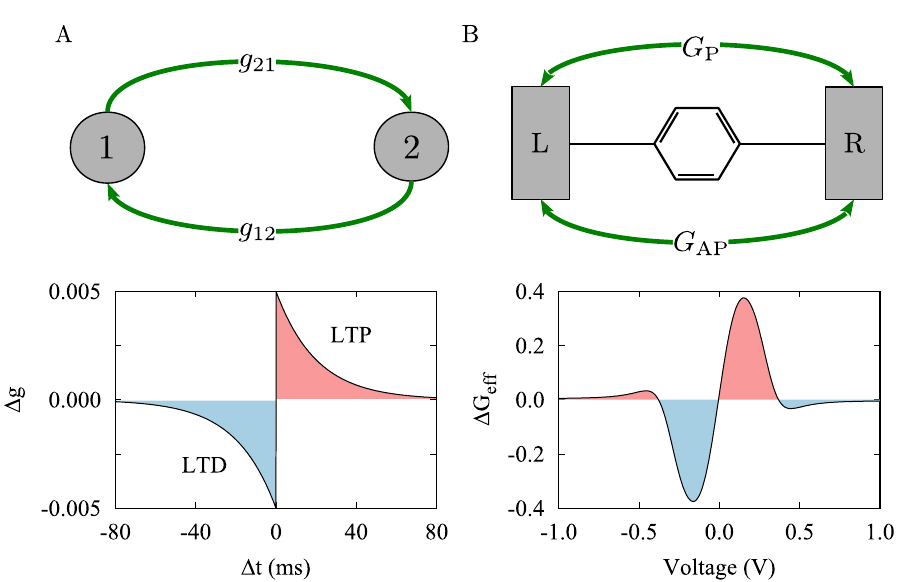
Fig 1. Schematic representation of the two-neuron motif and MTJ. ( A ) (Top) Two neuronal phase oscillators (1/2) reciprocally connected via synapses of strength g 21 / g 12 . (Bottom) The synaptic change governed by the classical temporally asymmetric STDP profile. STDP parameters were A + = A = 0.005 and τ + = τ - = 20 ms. ( B ) (Top) A single- − molecule MTJ composed of a PDT molecule connected to two FM cobalt electrodes (L/R) characterized by tunneling conductance in parallel ( G P ) and anti-parallel ( G AP ) configurations. (Bottom) The derivative of the effective conductance is calculated to provide a measure of its change.